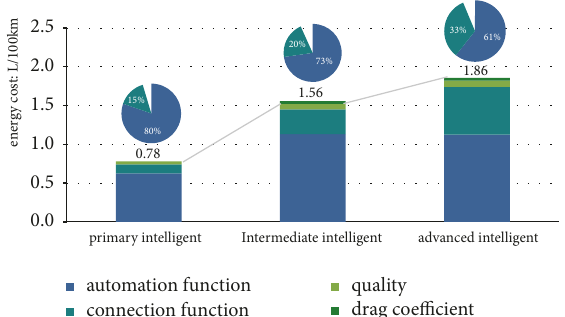
Figure 3: Vehicle fuel consumption cost at different levels of intelligence.